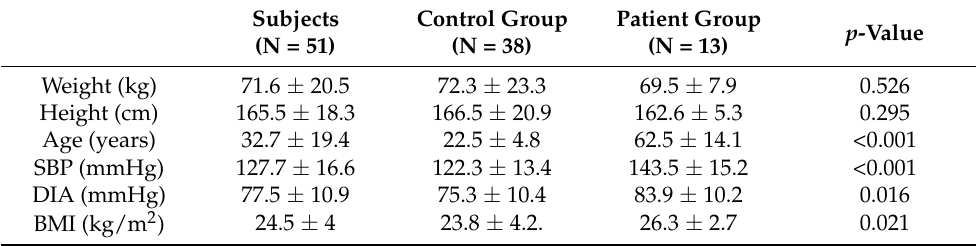
Table 1. Basic information of 51 subjects and their statistical